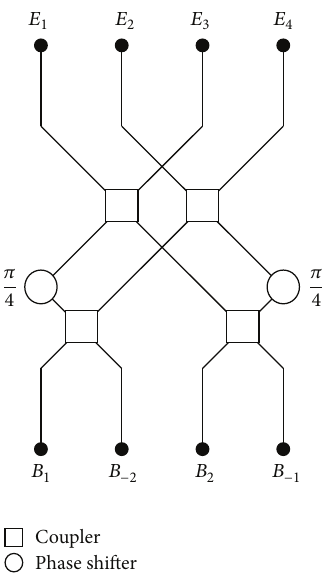
Figure 4: 4 × 4 symmetrical Butler matrix.